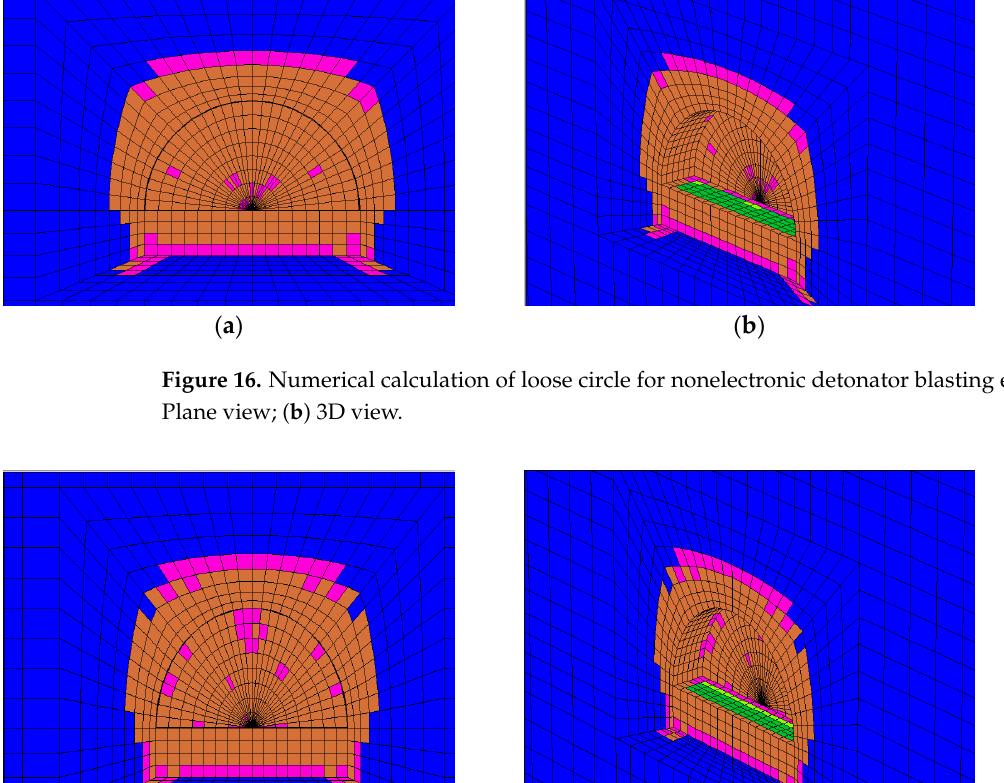
Figure 15. Data after electronic detonator vibration test and transition. The loose circles of the tunnel blasted by nonelectric detonators and electronic deto- nators were obtained by numerical calculation, as shown in Figures 16 and 17. The blue elements in the figures represent the undamaged surrounding rock. The green, brown and red elements represent the damage of surrounding rock, and the damage degree decreases in turn.